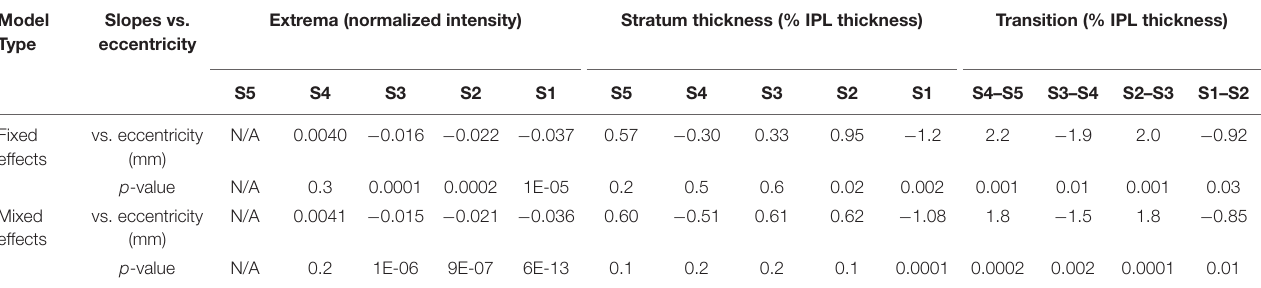
TABLE 1 | Summary of slopes versus eccentricity and their p -values for both fixed (fixed intercept and slope for each subject) and mixed (fixed intercept and slope, with independent random intercept and slope for subject grouping) effects